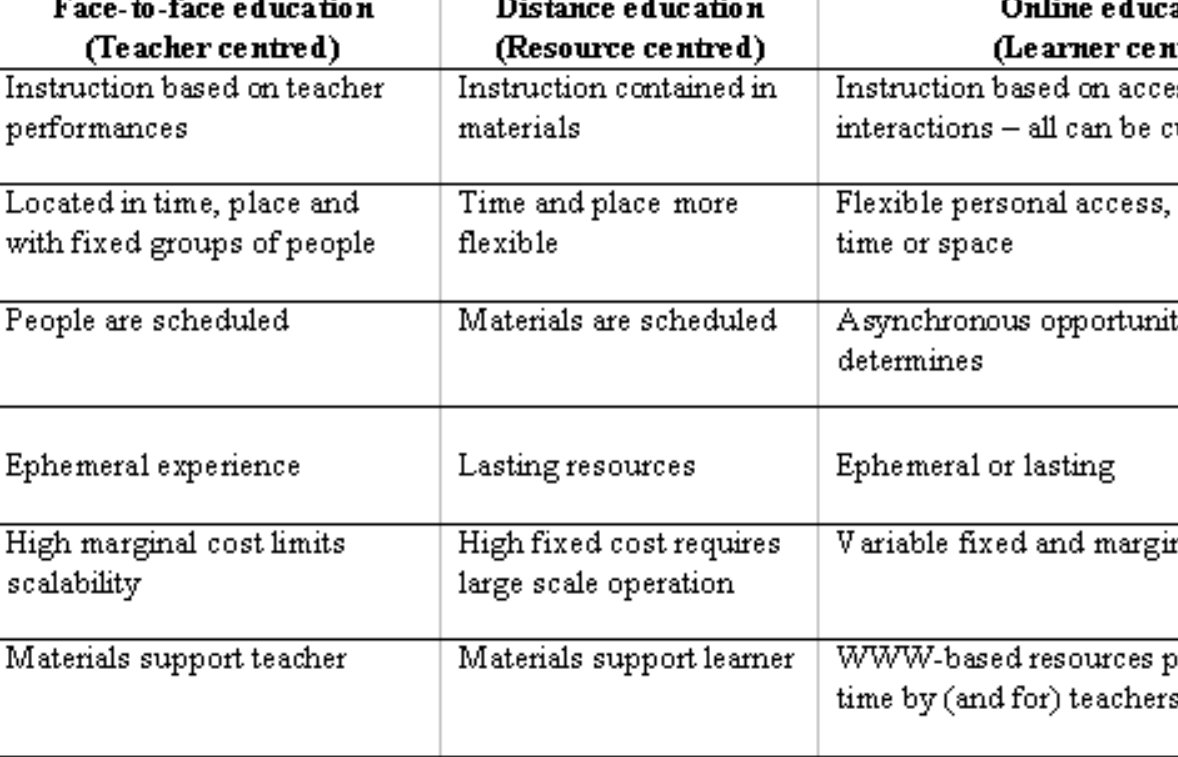
International Review of Research in Open and Distance